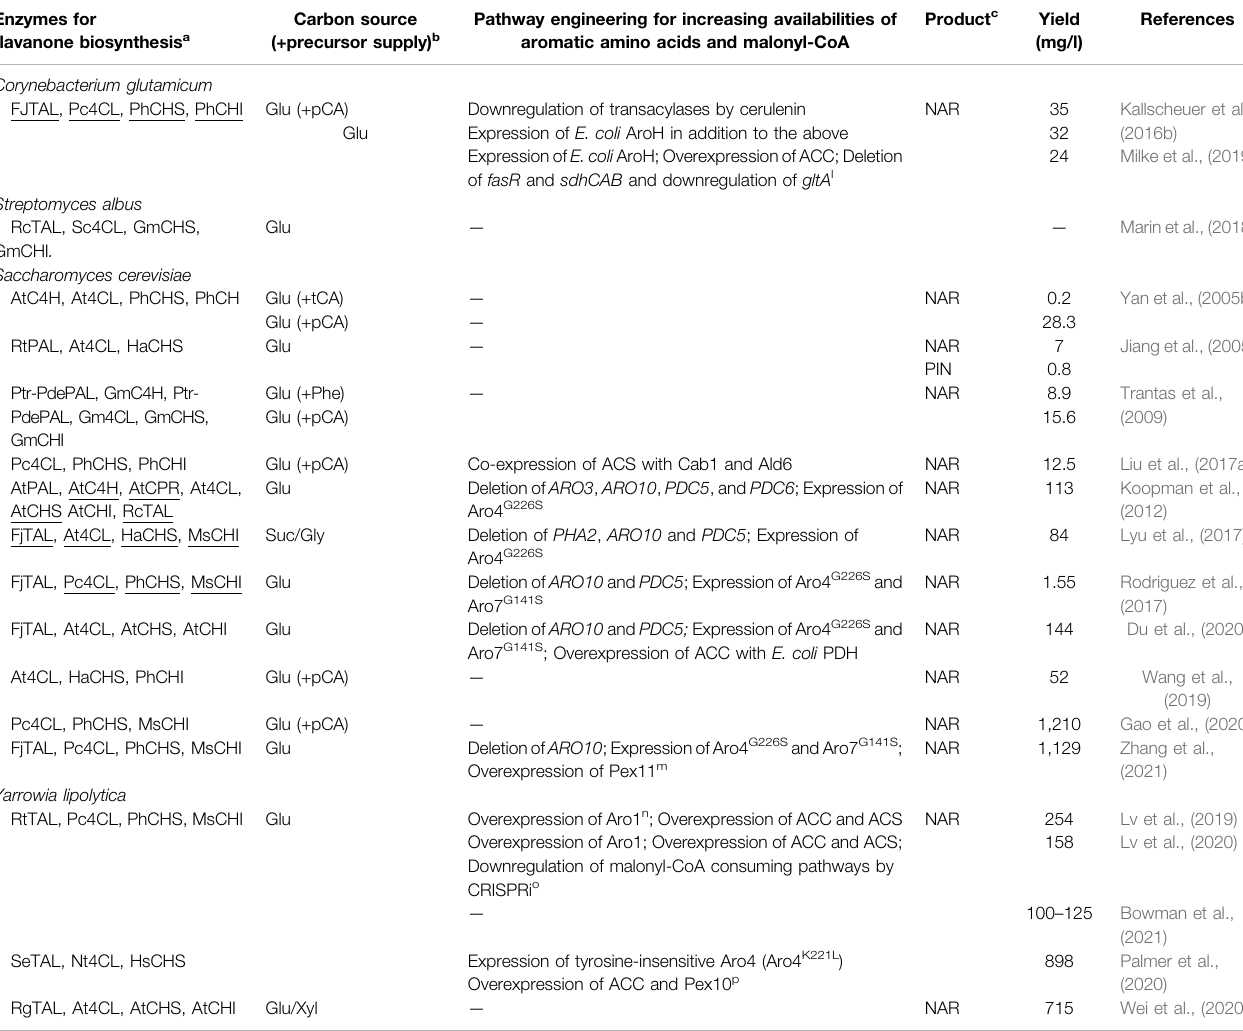
a Abbreviations are indicated in Table 4 . Codon of underlined enzymes are optimized for each host strain. b Glu, Gly, Suc, Xyl, Phe, Tyr, tCA, pCA, and CA represent glucose, glycerol, xylose, phenylalanine, tyrosine, trans-cinnamic acid, p-coumaric acid, and caffeic acid respectively. c NAR, PIN, EDT, and HEDT represent naringenin, pinocembrin, eriodictyol and homoeriodictyol respectively. d Knocked out genes are sdhABCD, citE (TCA, cycle), and adhE (ethanol synthesis) that encode succinate dehydrogenase, citrate lyase, and alcohol dehydrogenase